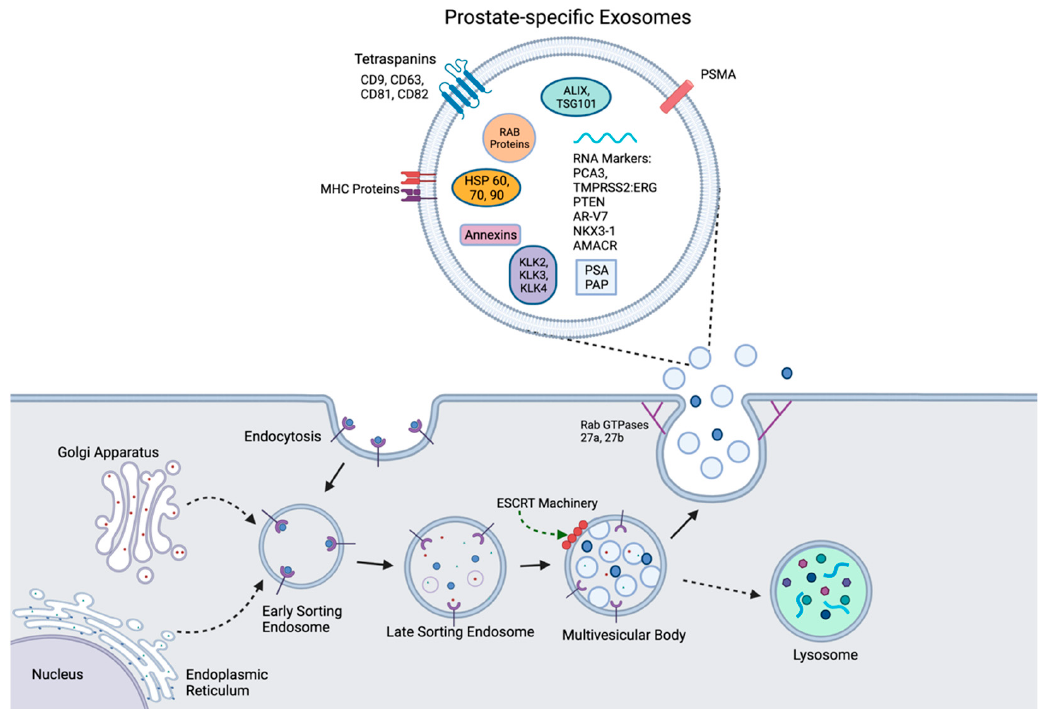
Figure 1. Biogenesis of prostatic exosomes. Endocytosis via cell membrane invagination creates an early sorting endosome (ESE), which combines with other ESEs from the Golgi apparatus and the endoplasmic reticulum to create a late sorting endosome (LSE). Via ESCRT-dependent or ESCRT-independent mechanisms, further invagination creates ILVs within a multivesicular body (MVB). The MVB may either be shuttled to a lysosome for degradation or to the cell surface with the help of MVB docking proteins, such as Rab GTPases 27a and b, to expel its contents, including exosomes, out of the cell. Prostate-specific exosomes (top) contain nonspecific exosome biomarkers, such as heat shock proteins and tetraspanins, while also including kallikreins, PSMA, PCA3, and TMPRSS2:ERG, which are specific to exosomes of prostatic